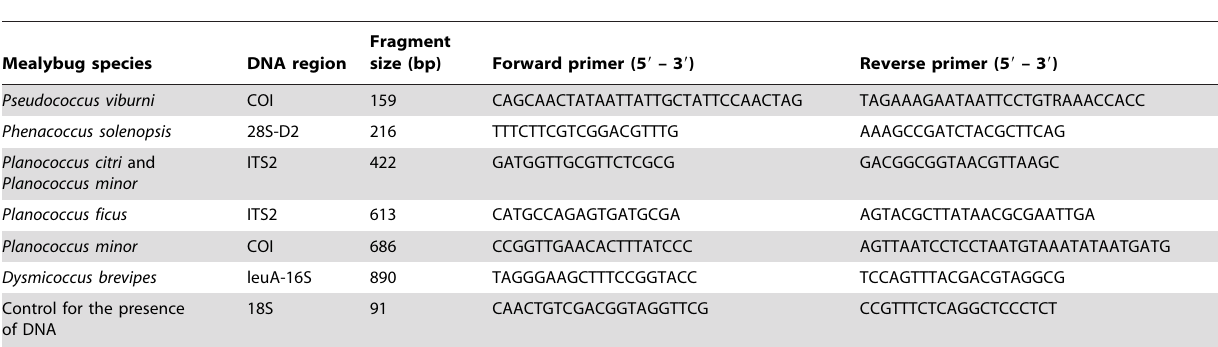
Table 4. Primers used for PCR